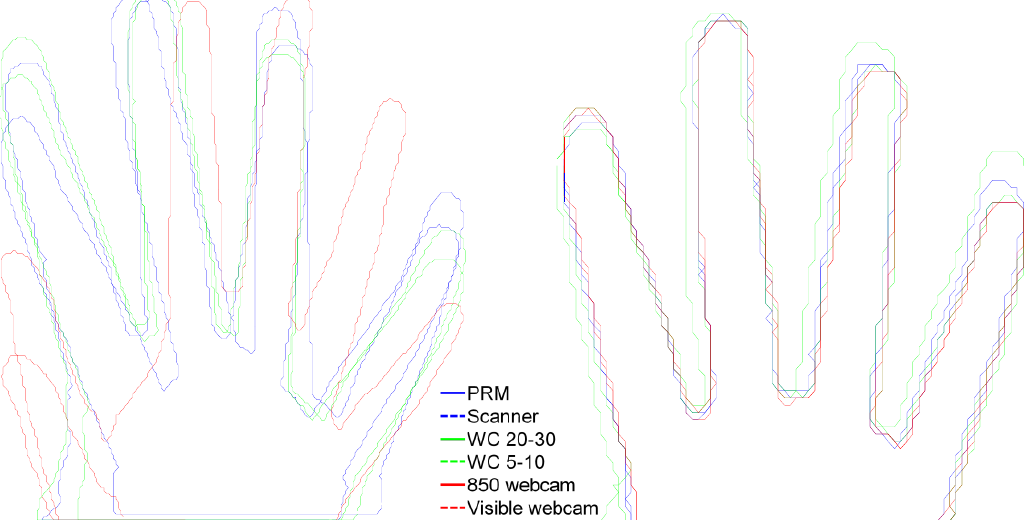
Figure 12. Superposed hand silhouettes registration images before finger normalization (left) and after finger normalization